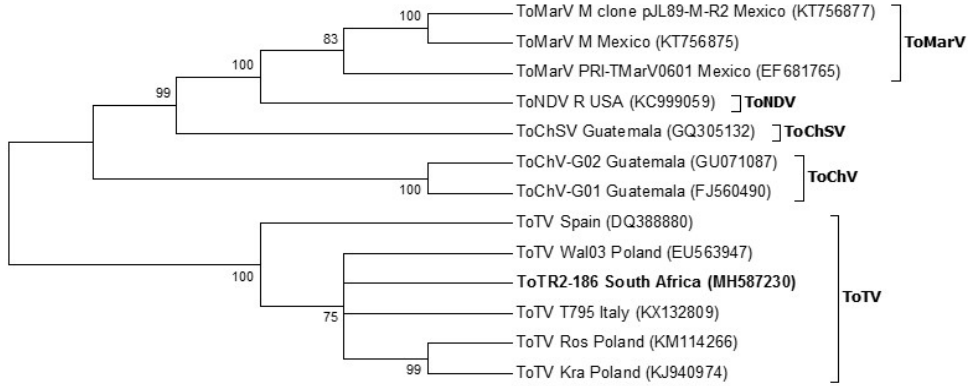
Figure 4. Phylogenetic relationship of the full-length RNA-2 genome from South Africa with all other fully sequenced tomato-infecting torradovirus isolates to date. Evolutionary analysis was carried out in MEGA 6 using the maximum likelihood method and 1000 bootstrap replicates based on the general time reversible model [23]. A gamma distribution rate ( g = 5) was used to model the evolutionary differences among sites. Accession numbers are in parenthesis.